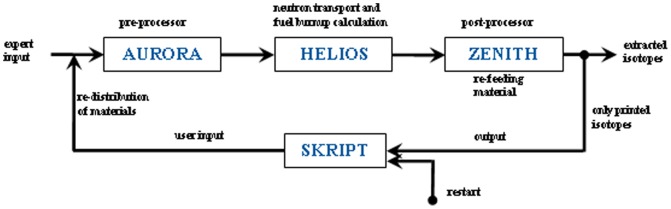
Description of the calculation cycle for the simulation of a MSR.